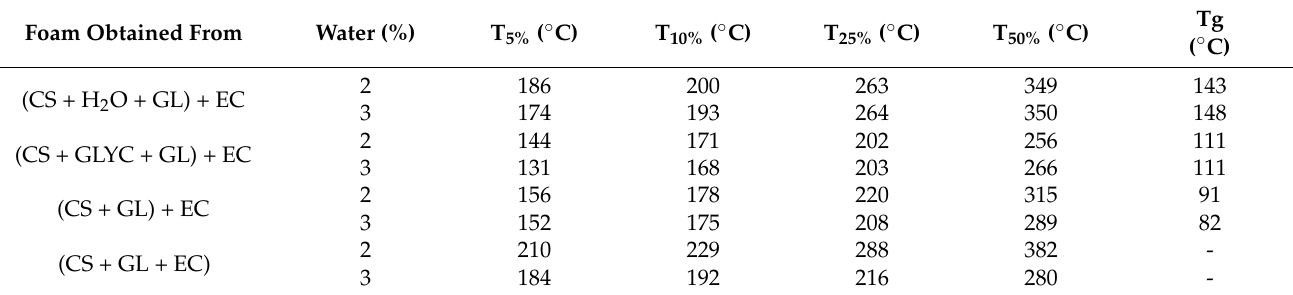
Figure 12. Thermal analysis of foams: mass change as a function of temperature ( a ) and differential mass change as a function of temperature ( b ) (the water content of 2% or 3% of the foam composition is based on 100 g of polyol). Table 9. Thermal analysis of foam determined by the dynamic method.